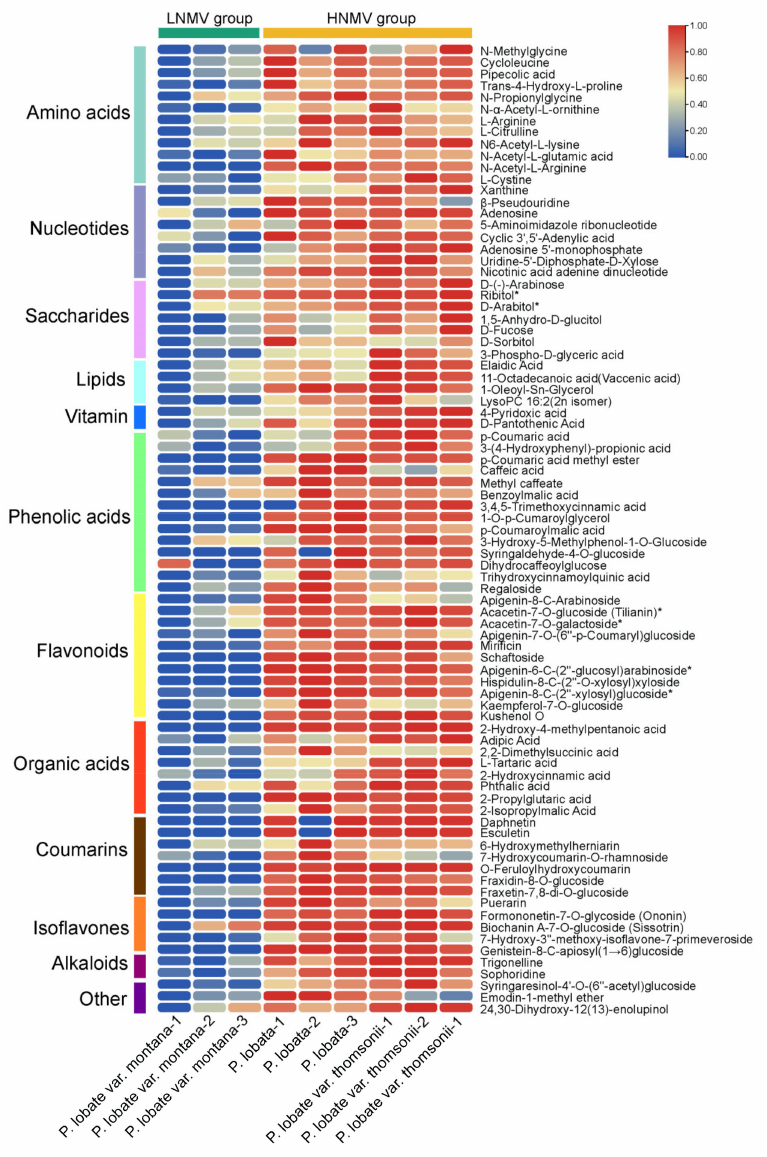
Figure 4. Heatmap of metabolites from root tuber samples of the HNMV group and the LNMV group. The color indicates the level of accumulation of each metabolite, from low (green) to high